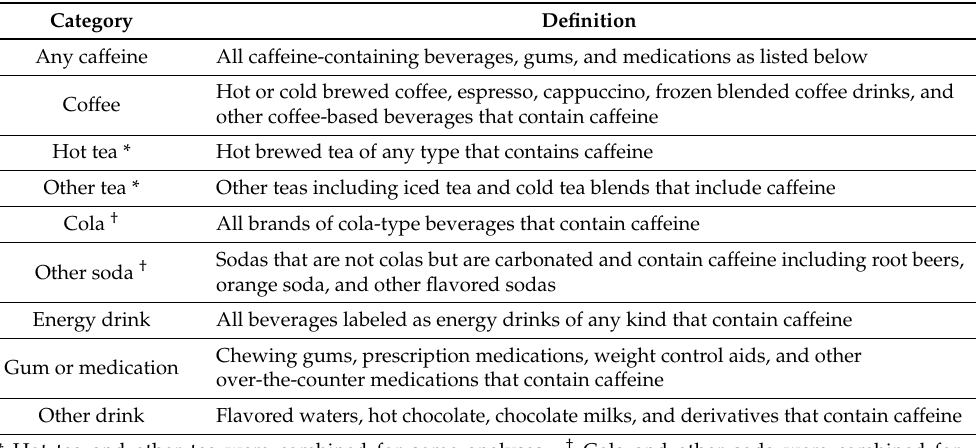
Table 1. Caffeine categories in study of United States Navy and Marine Corps